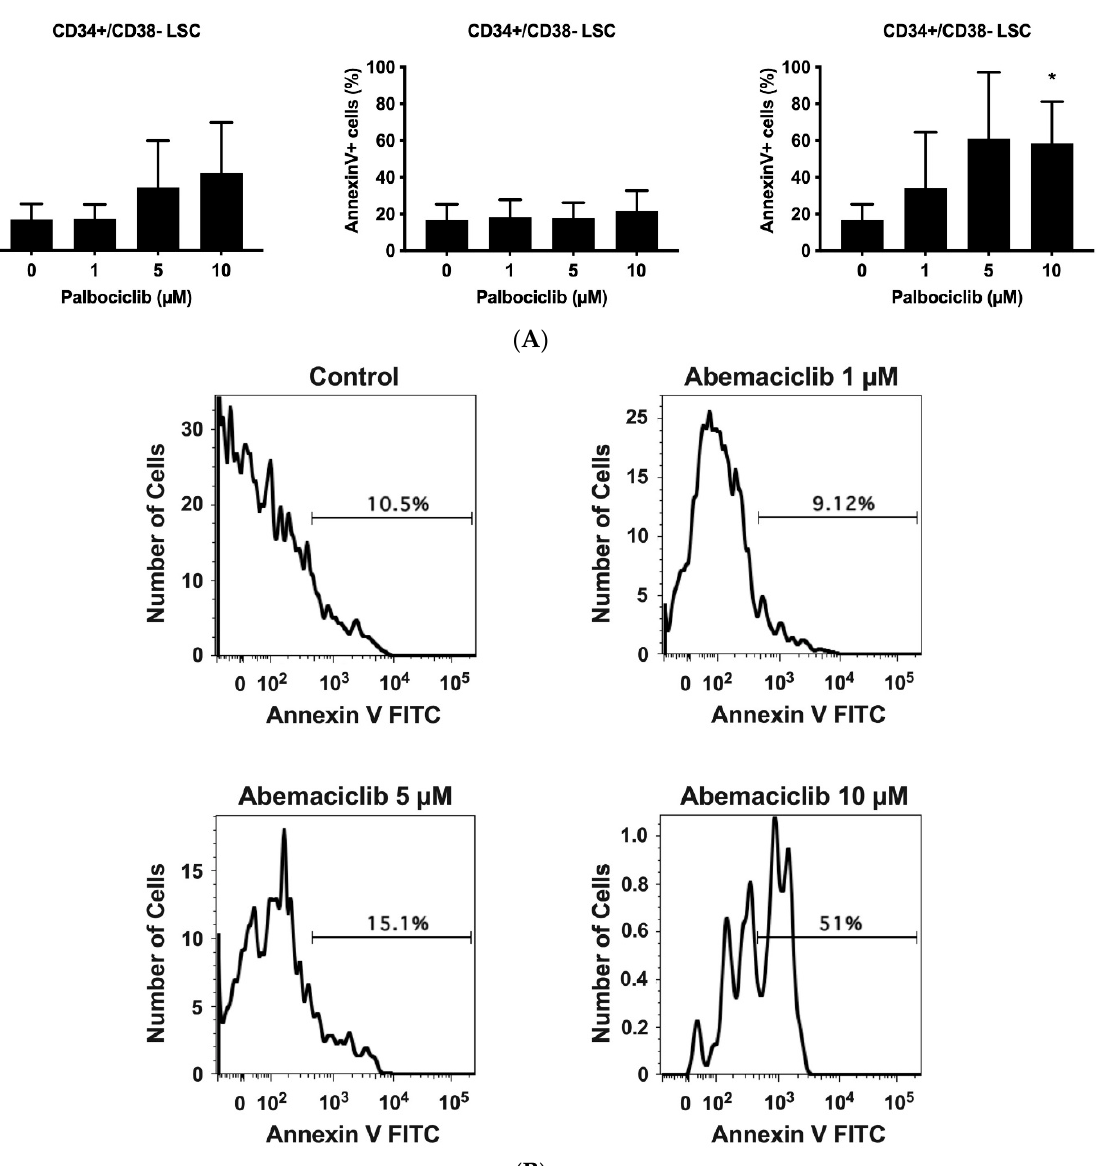
Figure 4. Palbociclib and abemaciclib induce apoptosis in CD34+/CD38 − LSC. ( A ): Primary neoplastic BM cells (patient #4.2, #5, #8, and #17 as referred to in Table 1) obtained from patients with AdvSM were exposed to control medium (Co) or palbociclib, ribociclib, or abemaciclib (1 µM, 5 µM, and 10 µM each) for 48 h. Thereafter, CD34+/CD38 − LSC were examined for signs of apoptosis by multicolor flow cytometry and staining for Annexin V-FITC and 4 ′ ,6-diamidino-2-phenylindole (DAPI). Results represent the mean ± S.D. of three patients (three independent experiments) and are expressed as percentage of AnnexinV+/DAPI − cells (of all CD34+/CD38- cells). ( B ): Histograms of one typical experiment (patient #4.2) are shown. Asterisk (*): p < 0.05 compared to control. Abbreviations: LSC, leukemic stem cells; AdvSM, advanced systemic mastocytosis, µM, micromolar.